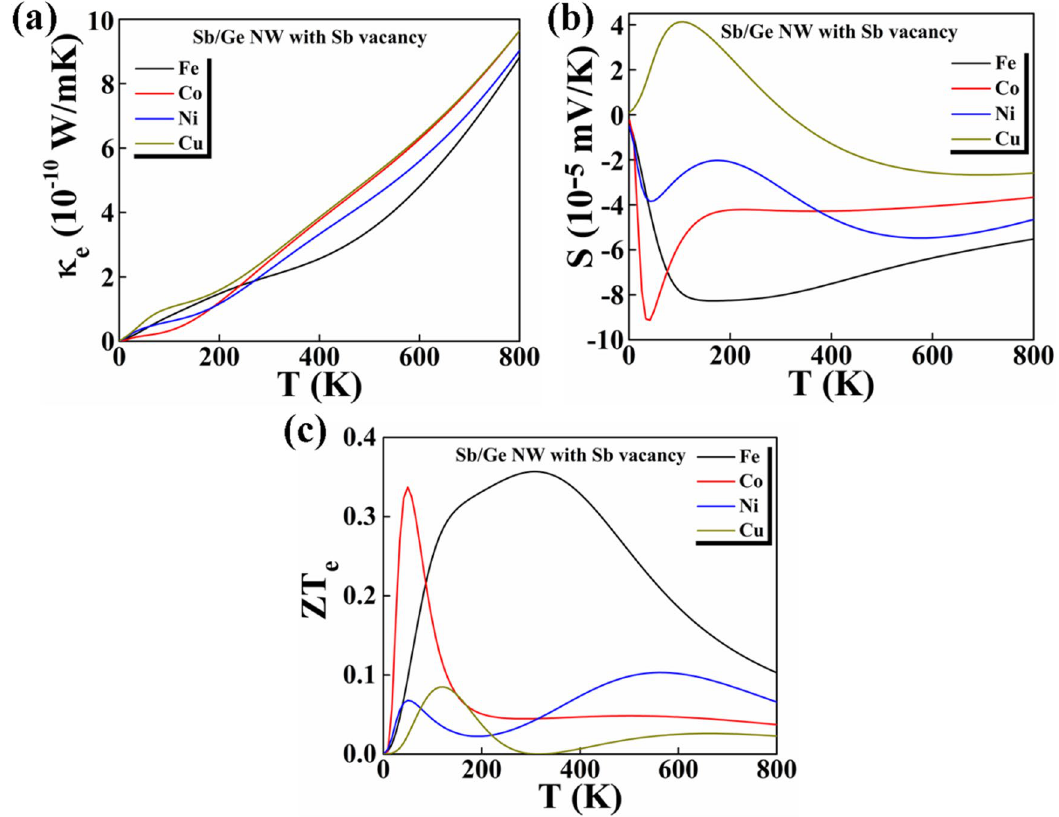
Figure 7. ( a ) Calculated electronic thermal conductivity, ( b ) Seebeck co-efficient and ( c ) figure of merit (ZT e ) of Sb/Ge NWs with Sb vacancy and one Fe, Co, Ni and Cu atom in the shell as a function of